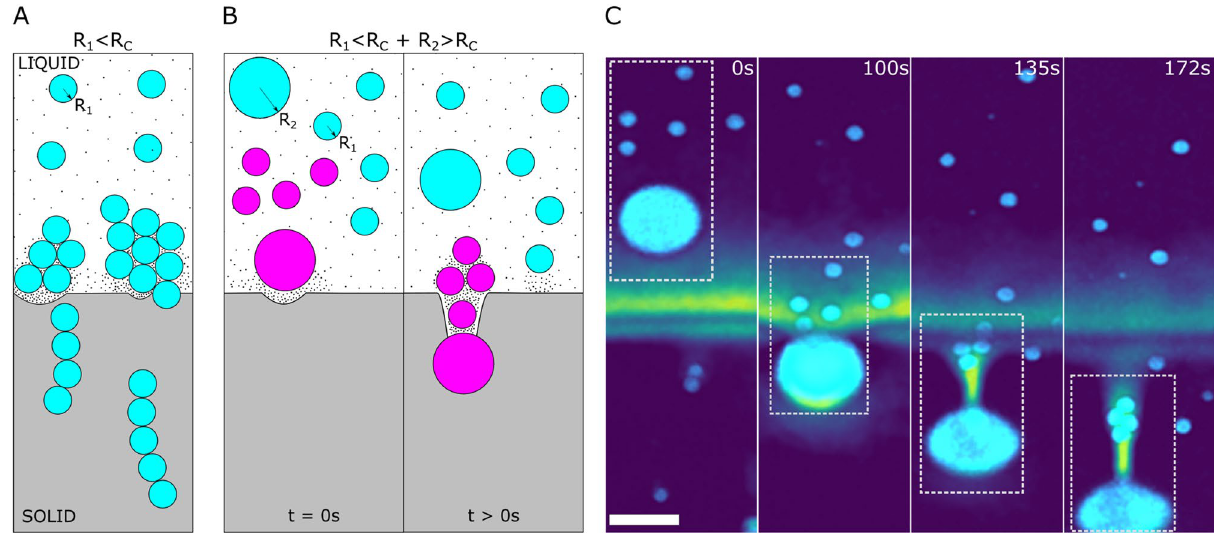
Figure 7. Interaction of bimodal oil-in-water emulsion with an advancing ice-water front with 1 wt.% bulk solute concentration. ( A ) Model sketch elucidating the previous experimental observations with 8 µ m monodisperse droplets ( R 1 ) with 1 wt.% solute in solution ( B , C ) Concave cusping of the solidification front is induced by the rejected solute segregation in the object-front gap and results in the formation of a solute-rich pocket. ( B ) Schematic depicting the formation of a pocket and subsequently induced object clustering with bimodal objects containing R 1 + R 2 objects, where R 1 < R c < R 2 . The small black dots in the panels A and B are a schematic representation of the solute. ( C ) Experimental observation showing engulfment of 8 µ m oil droplets in pockets initially induced by 28 µ m droplets. The droplets are far apart in water at t = 0 s , get clustered at the fermeture of the solute-rich pocket ( t = 135 s ), and at t = 172 s get further close-packed owing to the lateral growth (along (cid:31) y ) of the ice crystals. Oil is in cyan, water in colormap viridis (fluorescence bar) while ice is in black. Scale bar = 100 µ m . © (2020) S. Tyagi et al. (10.6084/m9.figshare.13176221) CC BY 4.0 license https ://creat iveco mmons .org/licen ses/by/4.0/.